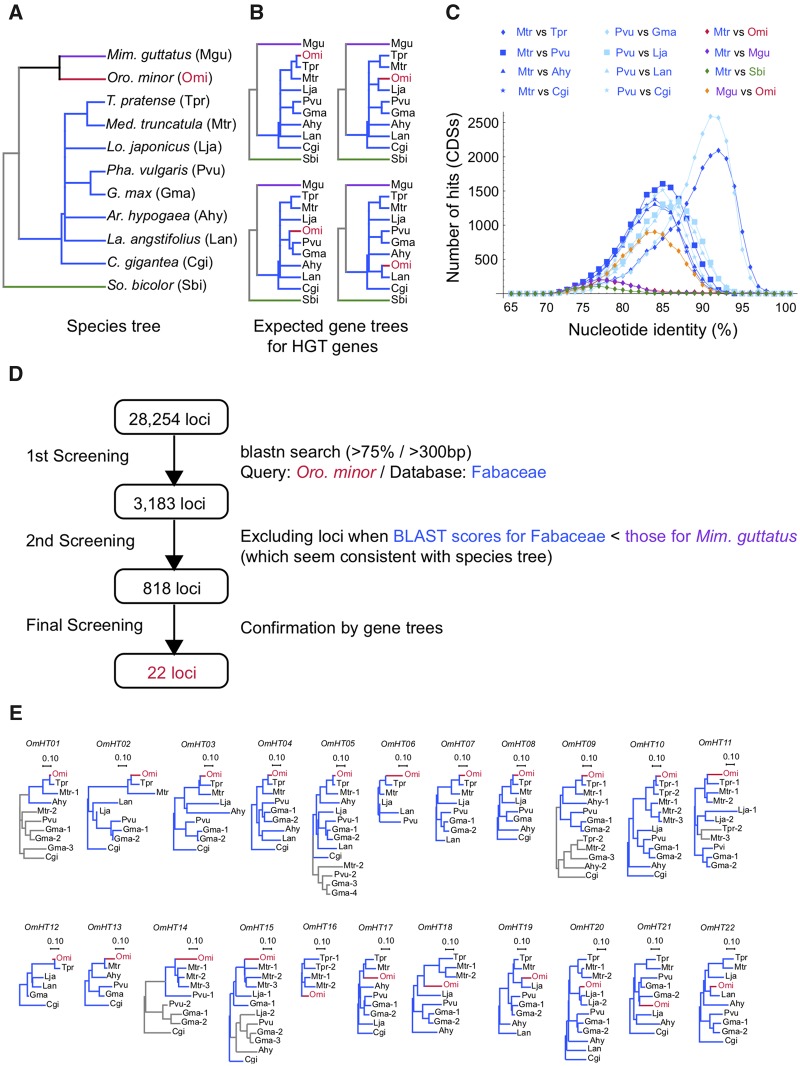
—Summary of the screening process for Orobanche minor. (A) Species tree of Oro. minor and eight species in Fabaceae (blue) together with two species used as outgroups (Mimulus guttatus and Sorghum bicolor). (B) Typical gene trees expected for HGT genes. (C) Distributions of nucleotide identity between species. (D) Screening scheme. (E) Gene trees for the 22 HGT genes, labeled from OmHT01 to OmHT22. The branch lengths in the trees are based on pairwise distance at synonymous sites with the Jukes–Cantor correction. Bootstrap values (>75%) are shown on branches. Red and blue branches are for the parasite (Oro. minor) and its homologs in Fabaceae. When paralogs were detected in Fabaceae, their lineages are shown in gray.